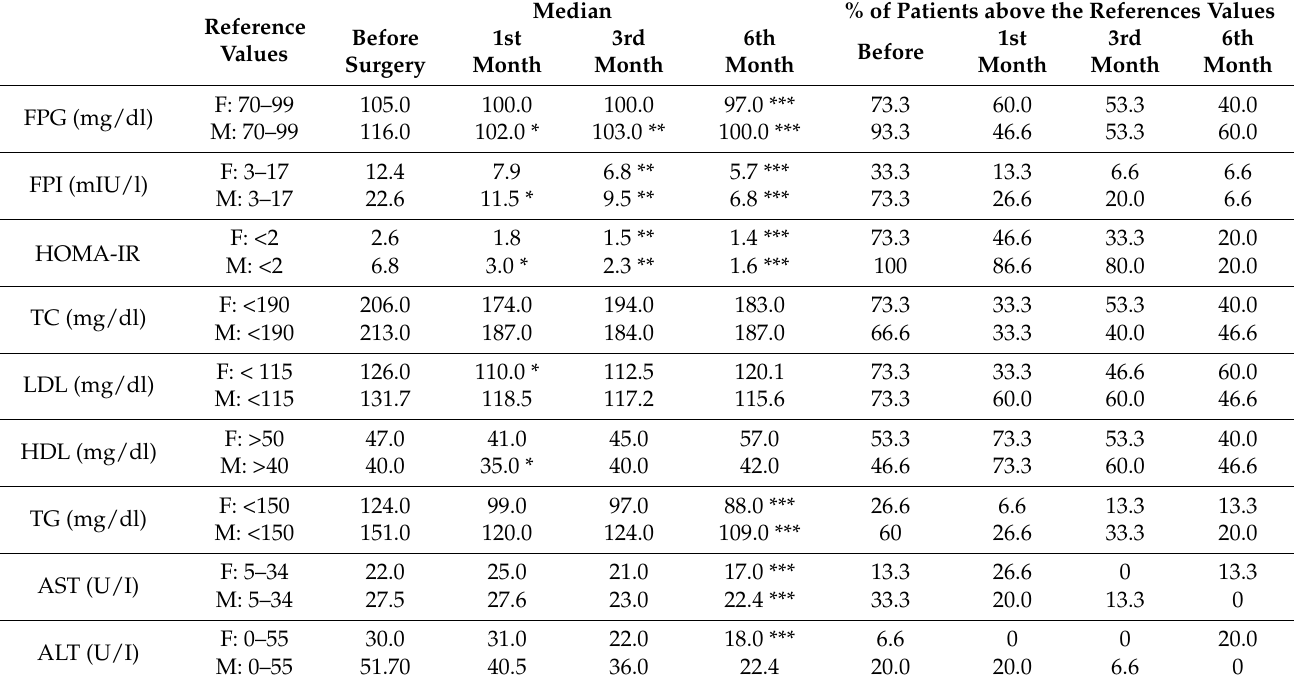
Table 2. The values of blood biochemical parameters of women and men before and 1, 3, and 6 months after LSG and the percentage of patients with results above the reference